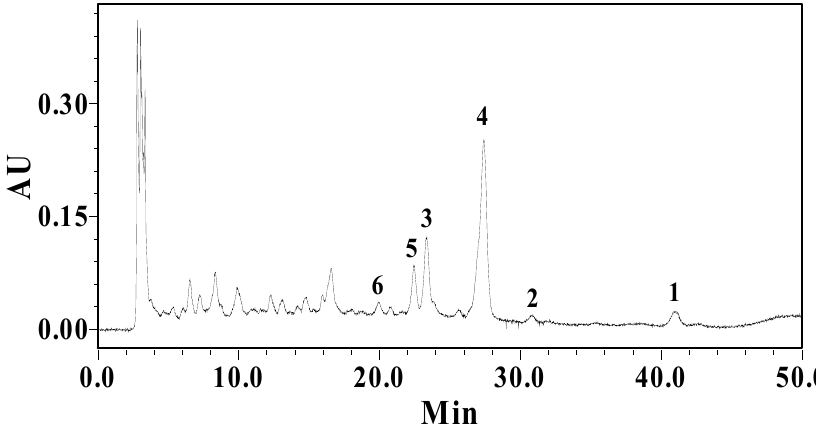
Figure 3. HPLC analysis of the ethanol extract of C. sinica